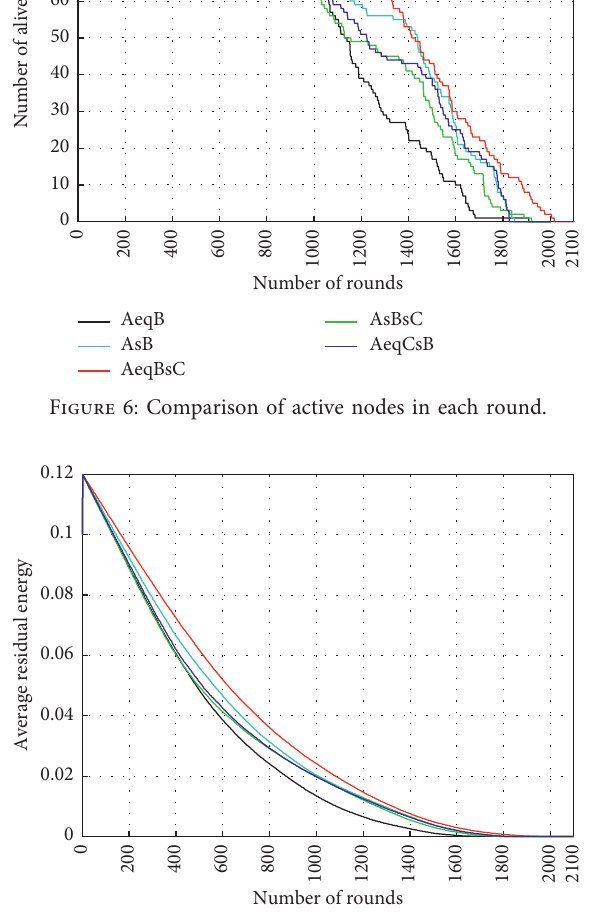
� S b . (c) Partitioning scheme 1: S a